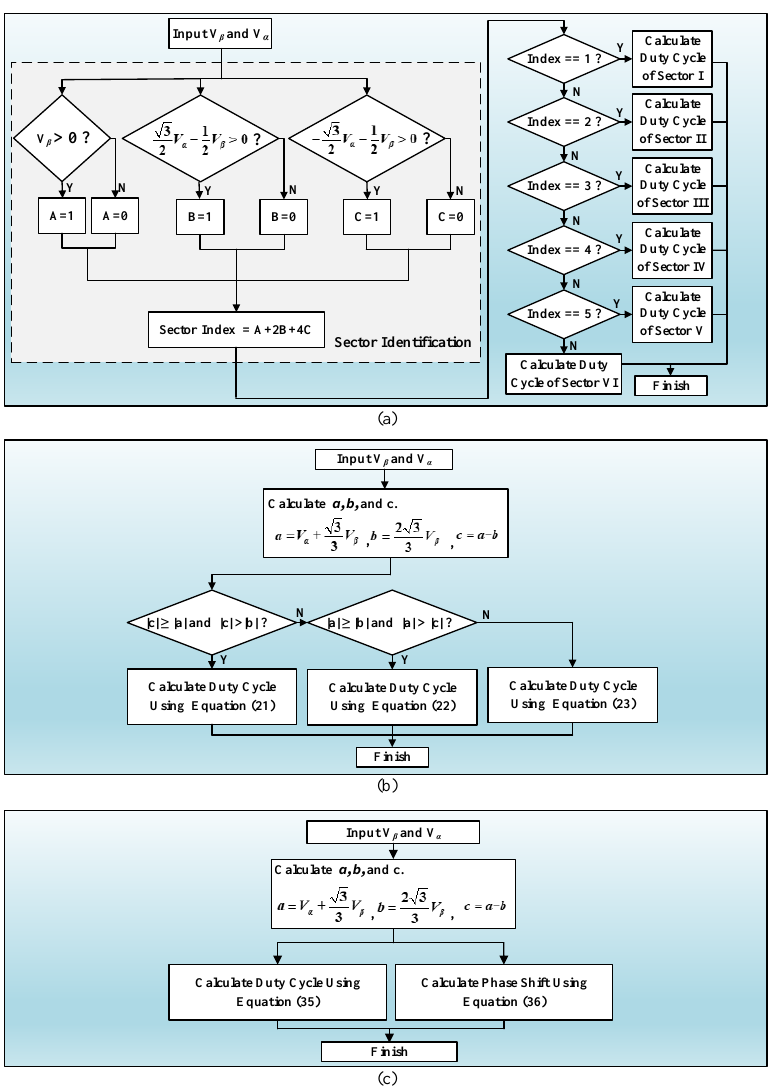
Figure 10. ( a ) The flowchart of the conventinal SVPWM algorithm. ( b ) The flowchart of the proposed SVPWM algorithm with the OVDT of the 1-norm. ( c ) The flowchart of the proposed SVPWM algorithm with the OVDT of the